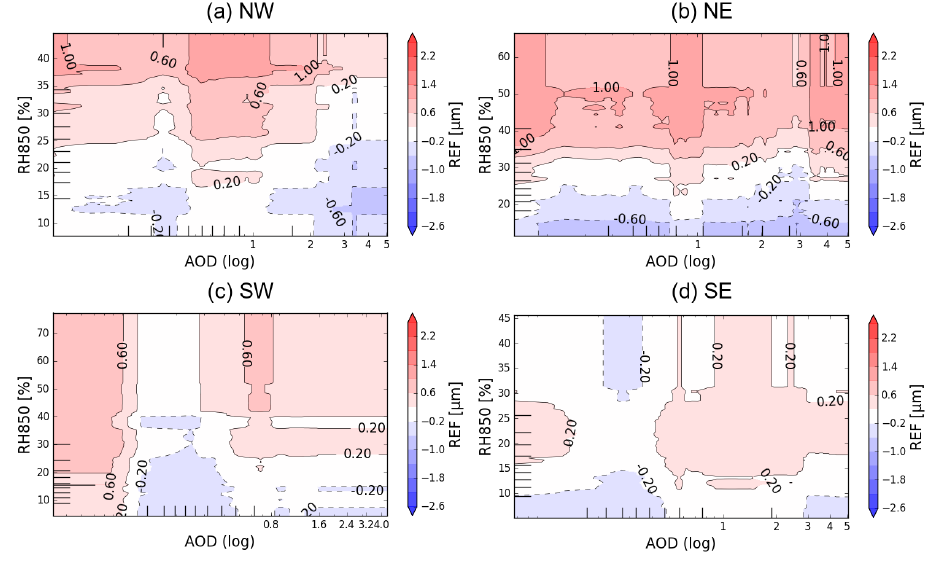
Figure 12. Two-variable partial dependence of REF on RH850 and AOD in the four subregions NW, NE, SW and SE during JAS. Description as in Fig.